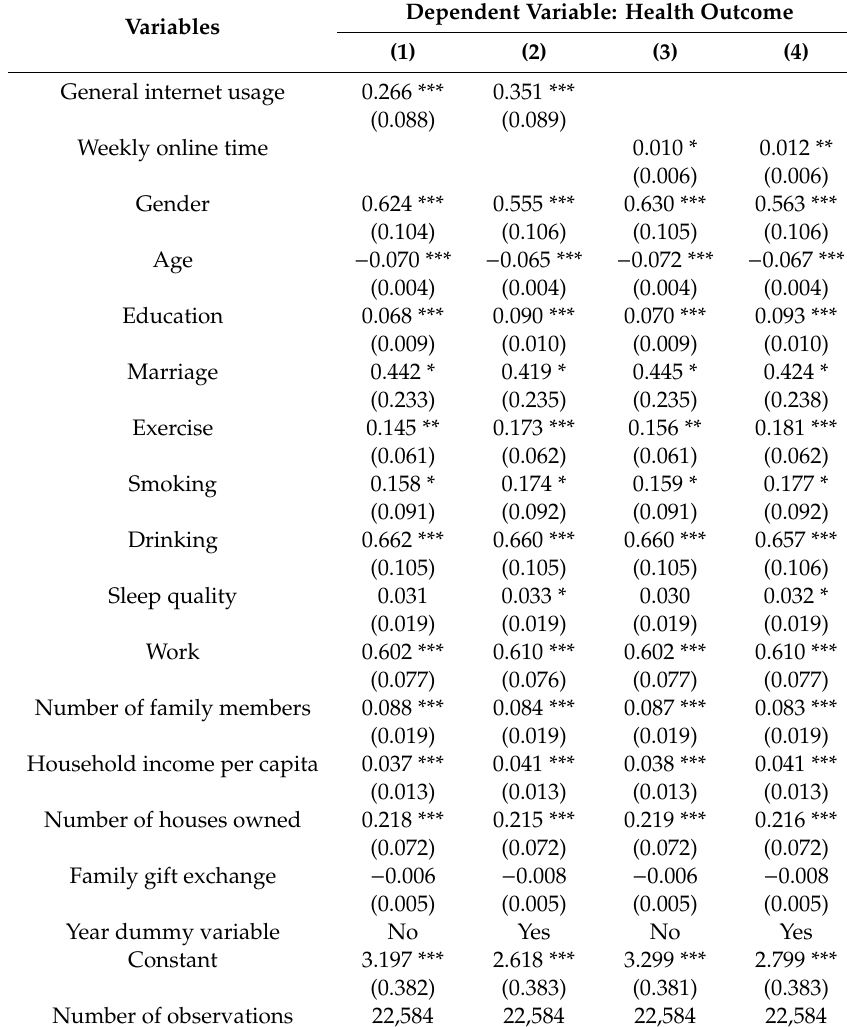
Table 2. Impact of internet use on health outcomes of rural